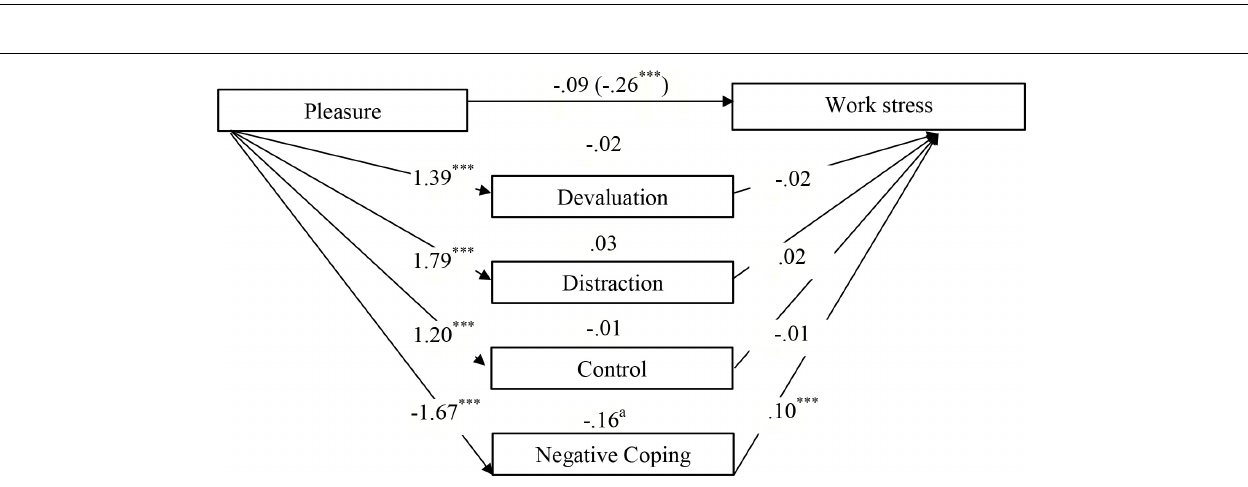
Frontiers in Psychology |